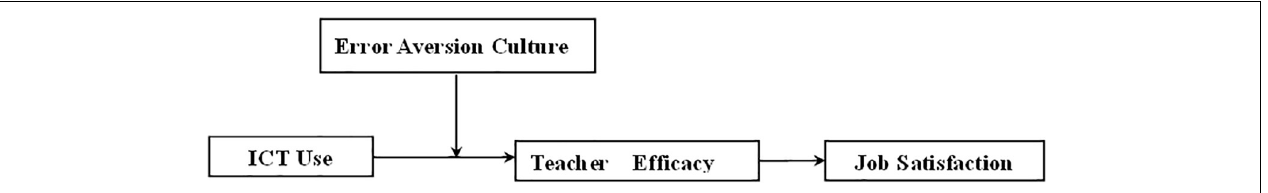
FIGURE 1 | The proposed model of ICT use and job